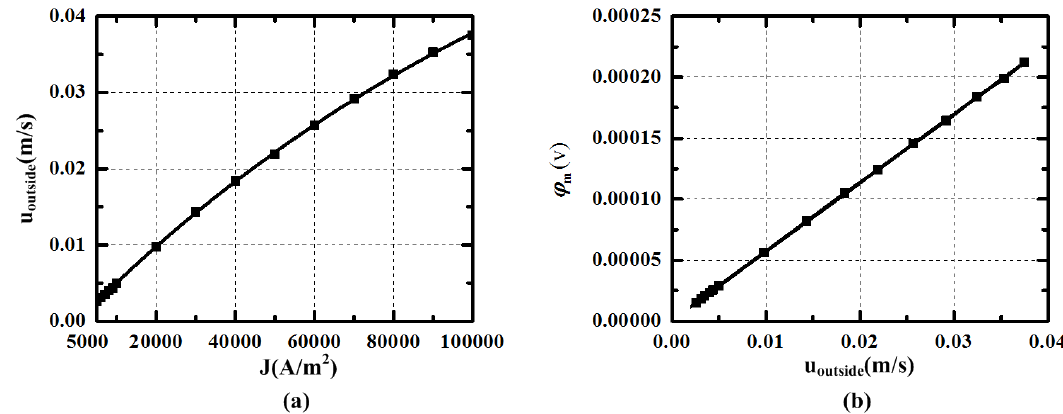
Figure 9. ( a ) The velocity u outside in outside channel varying with current density J ( u outside is the facet average velocity at r = 28 in the outside channel); ( b ) The potential difference ϕ m between measuring electrodes varying with current density J in simulation.